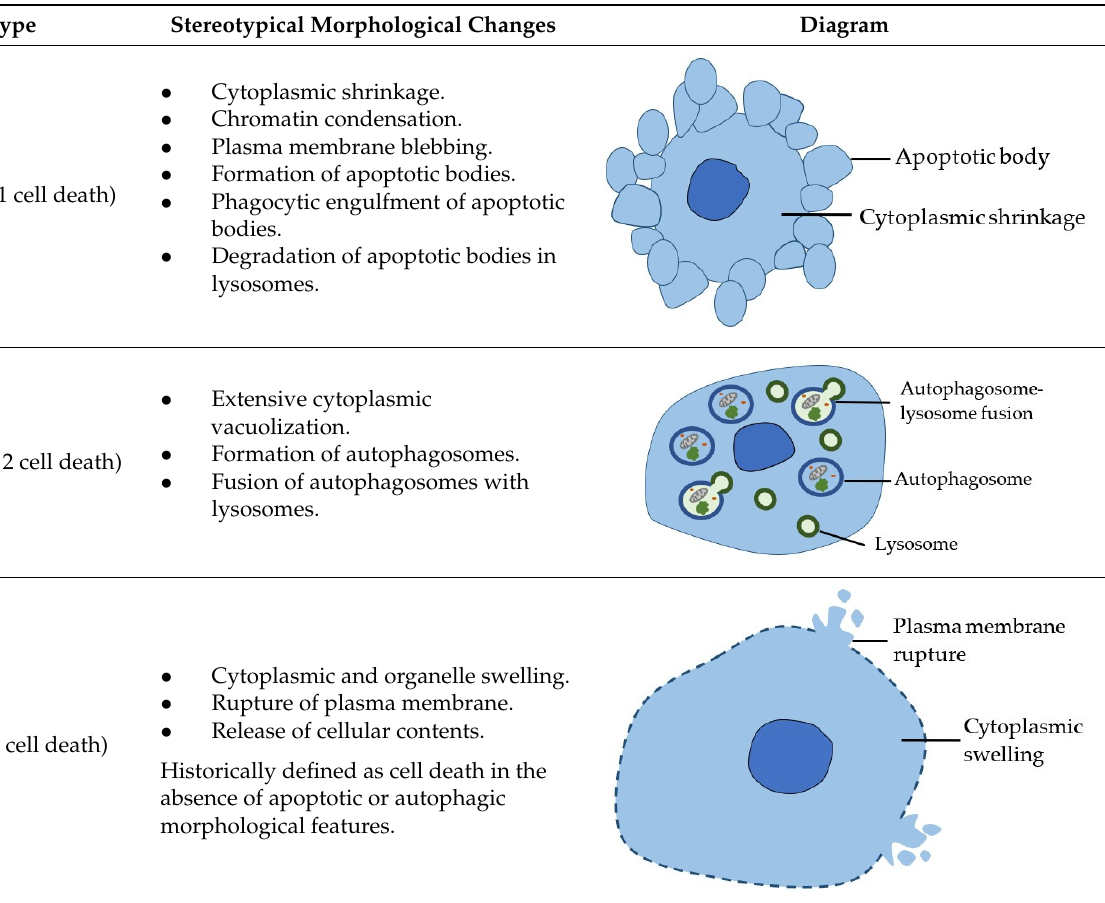
Table 1. Historical classification of cell death based on stereotypical morphology.